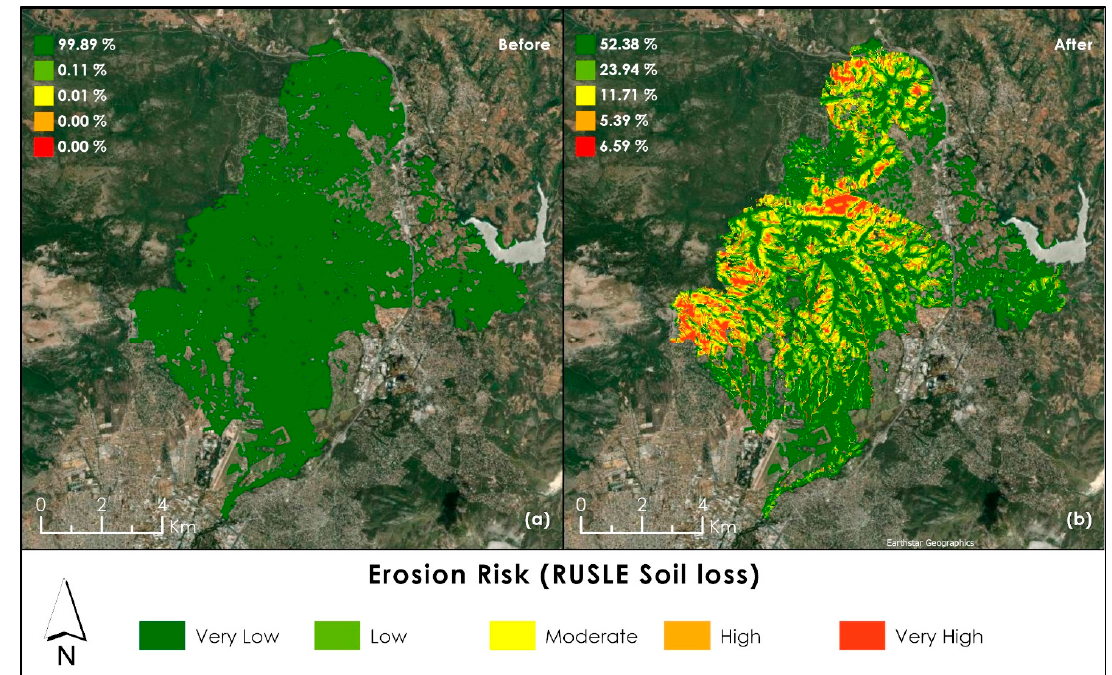
Figure 5. Erosion Risk according to RUSLE soil loss for Schinos burned area: ( a ) before the fire; ( b ) after the fire. The erosion risk as classified is presented including the percentage of the burned area total of each area per class.